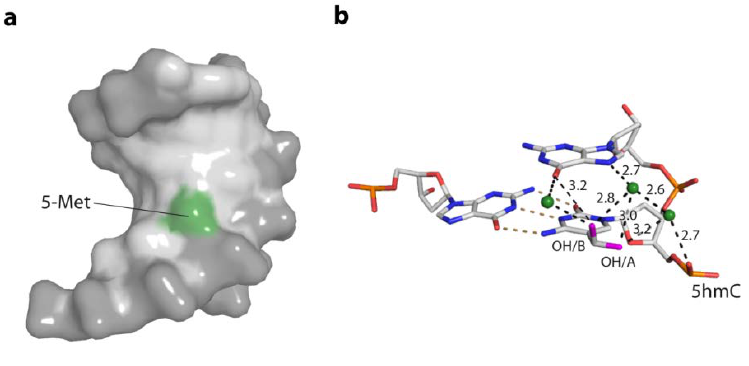
Figure 6. Structural bases for the increased stiffness of DNA containing the epigenetic bases 5mC and 5hmC. ( a ) The 5-methylgroup of 5mC (green) reaches in the major groove of the DNA, altering the charge distribution and steric properties in the major groove; (PDB code 4C63) ( b ) Direct and water-mediated hydrogen bonding of the two alternative hydroxyl conformations (pink) of 5hmC to the 3' base and phosphate backbone. Water molecules are depicted as green spheres. (PDB code